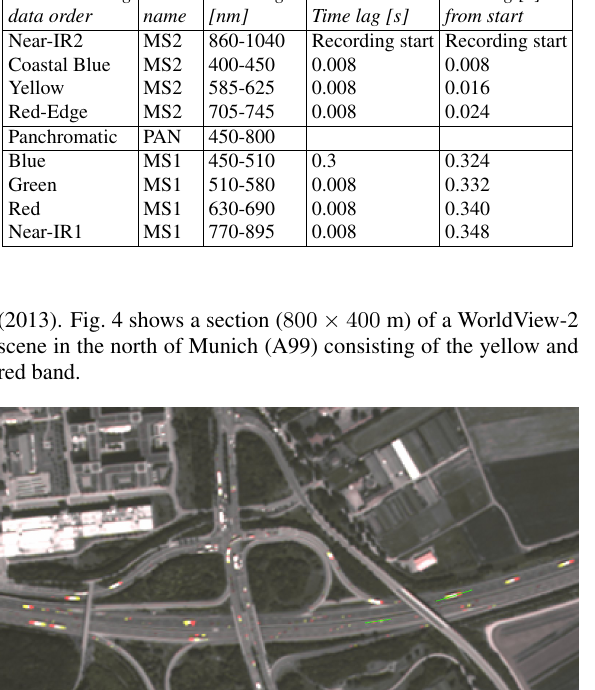
Table 1: WorldView-2’s recording properties Band recording Sensor Wavelength Inter-band